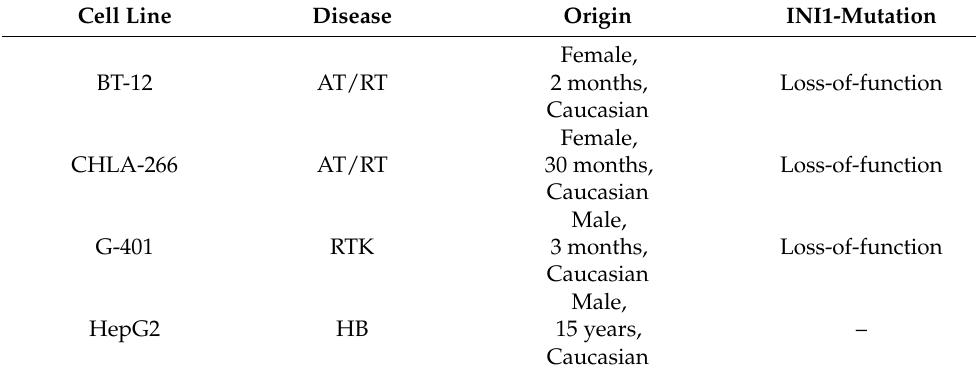
Table 1. Summary of characteristics of cell lines. Cell Line Disease Origin INI1-Mutation Female, BT-12 AT/RT